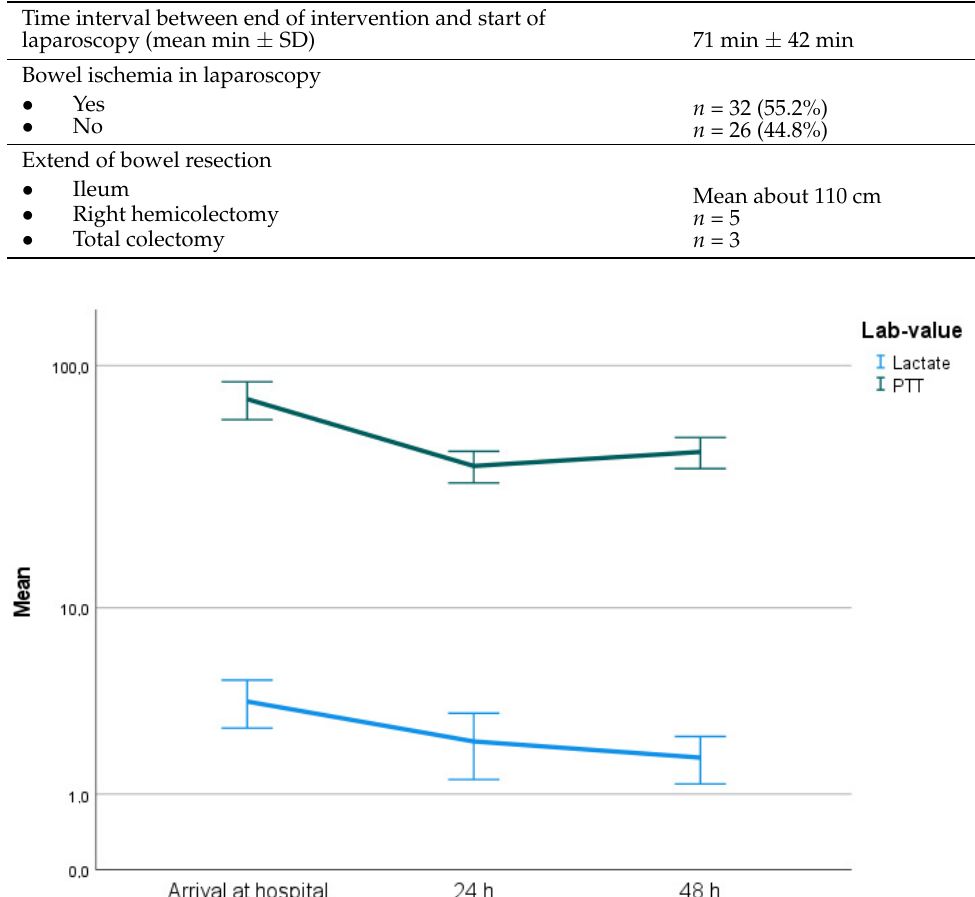
Figure 2. Significant decrease in serum lactate levels ( p < 0.001) and in serum PTT ( p < 0.001).